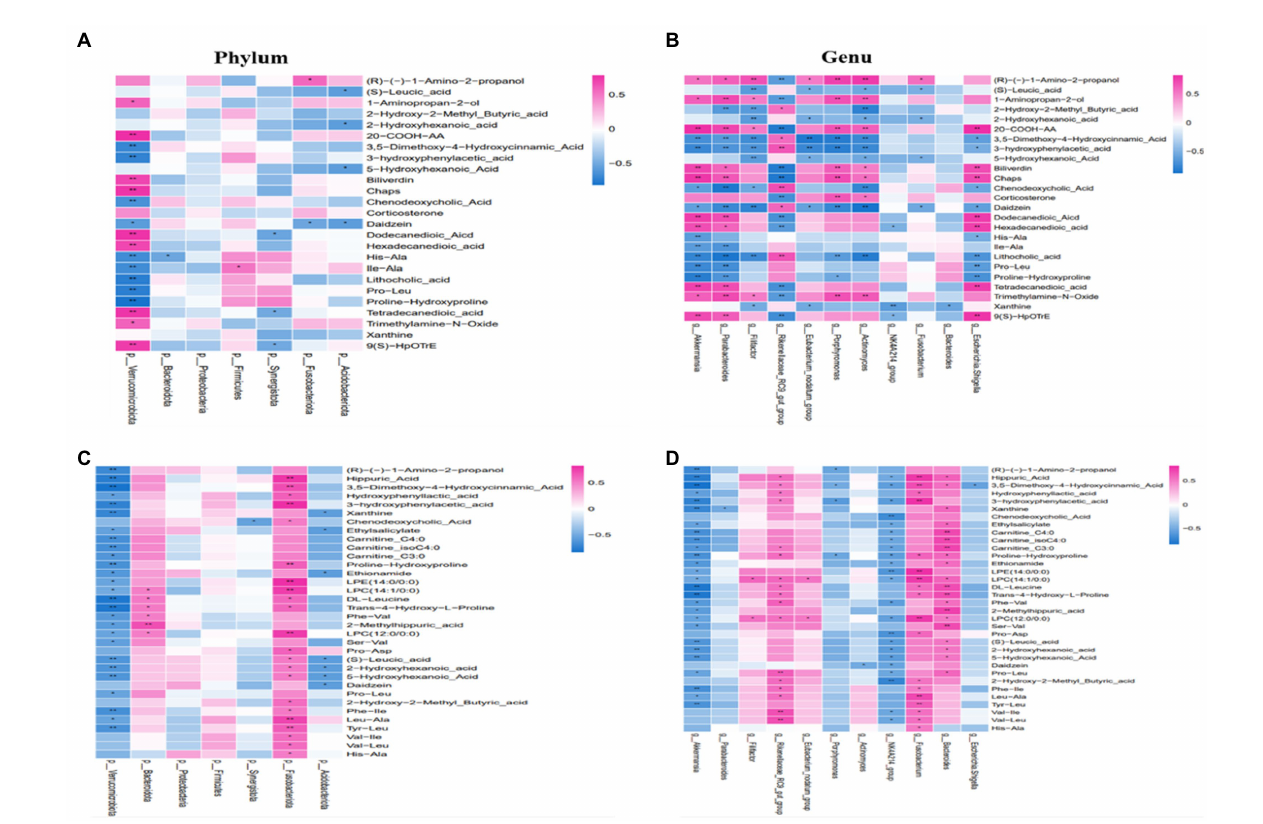
FIGURE 7 The correlation between gut microbiota and serum metabolites. At the phylum or genera level in the CON and RF groups (A,B) . At the phylum or genera level in the CON and ARF groups (C,D) . Red represents positive correlation, and green represents negative correlation. * p < 0.05, ** p <